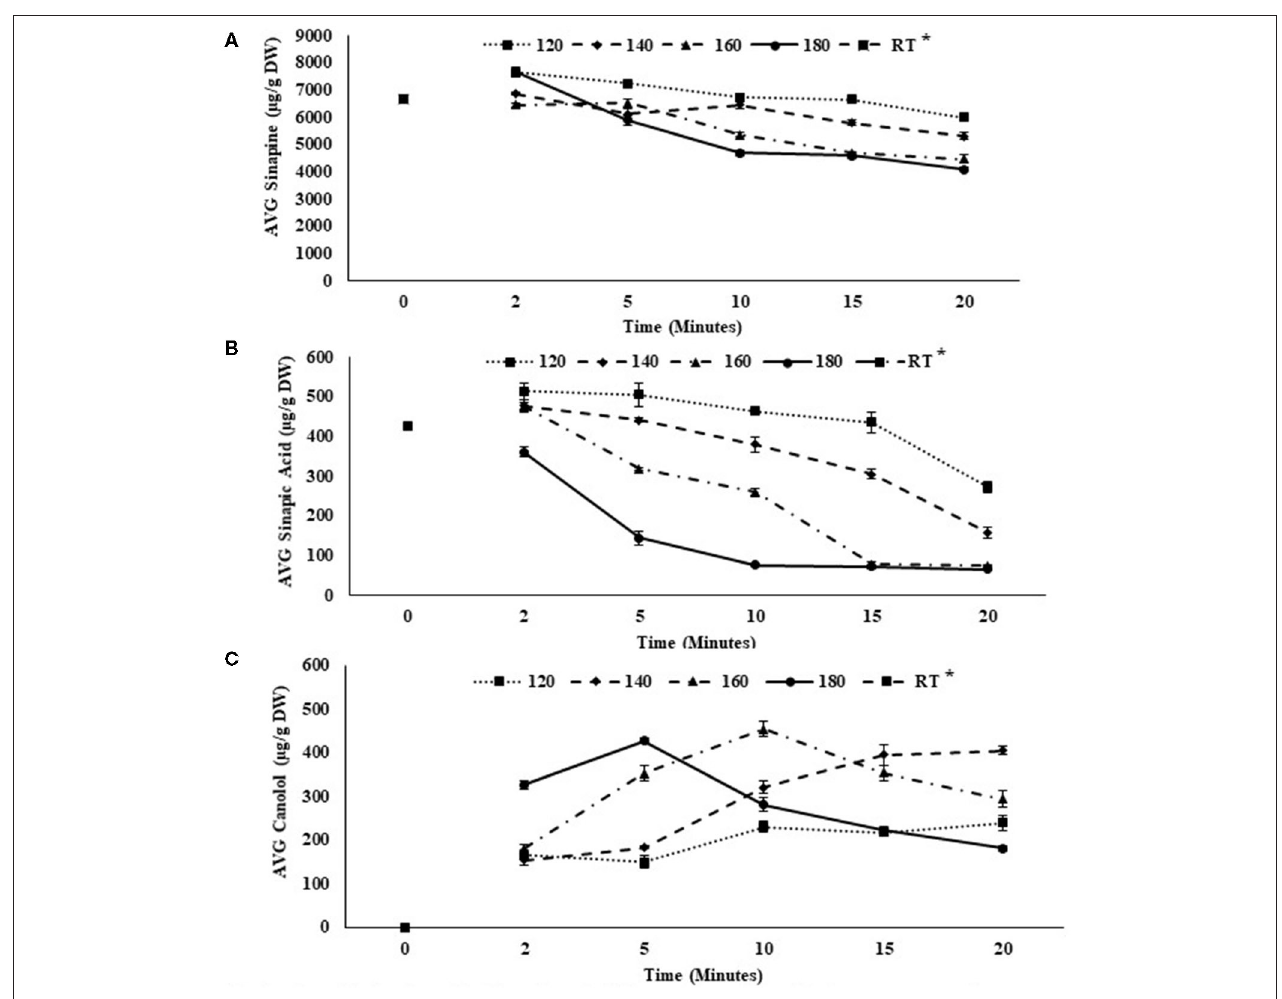
FIGURE 3 | Changes in sinapine (A) sinapic acid (B) and canolol (C) concentration with the temperature-time pre-treatment for canola meal (* RT, Room Temperature).